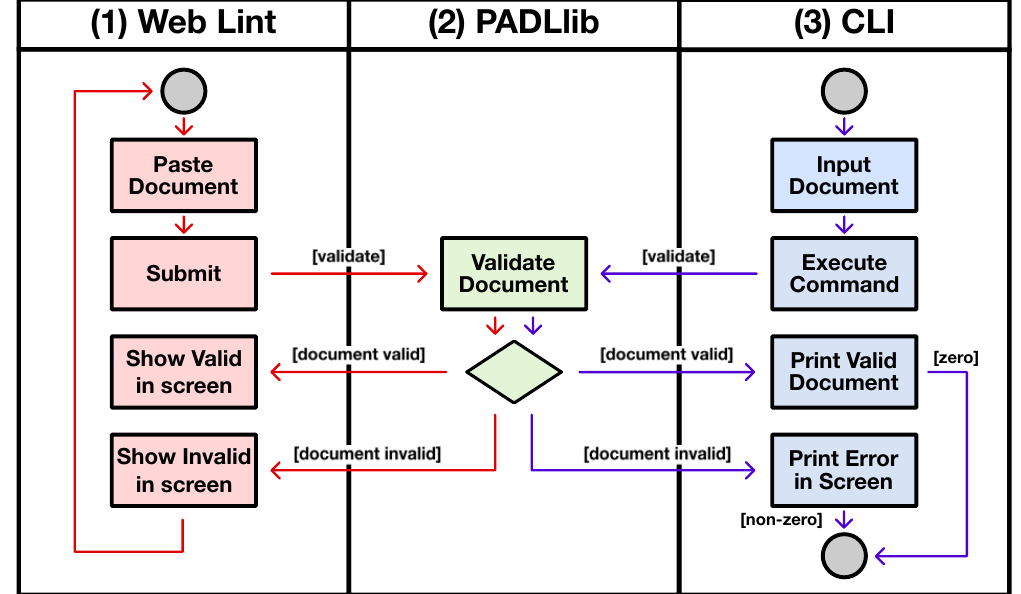
Figure 16. Activity diagram showcasing the interaction of the PADL library with the Web Lint and Command Line (CLI)